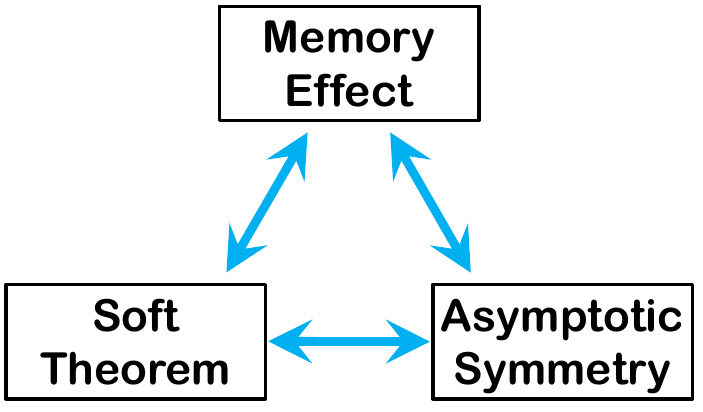
Figure 1 . Triangular relation among soft theorem, asymptotic symmetry and memory e(cid:11)ect. number of conserved charges. One can show that the charge conservation is equivalent to the scalar memory e(cid:11)ect discussed in [38, 43]. However, the theories in [45] su(cid:11)er from the infrared divergences, and in general, the scalar boson acquires (cid:12)nite mass at loop level. In this paper, we consider the case that the massless scalar is a NG boson. Unlike the model considered in [45], we consider a theory without infrared divergences, and massless- ness of scalar is ensured from the NG